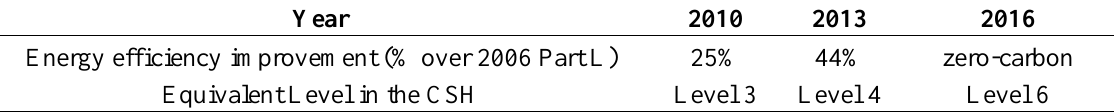
Table 4. Tightening of Part L towards achieving zero-carbon homes. Data from [7,8].